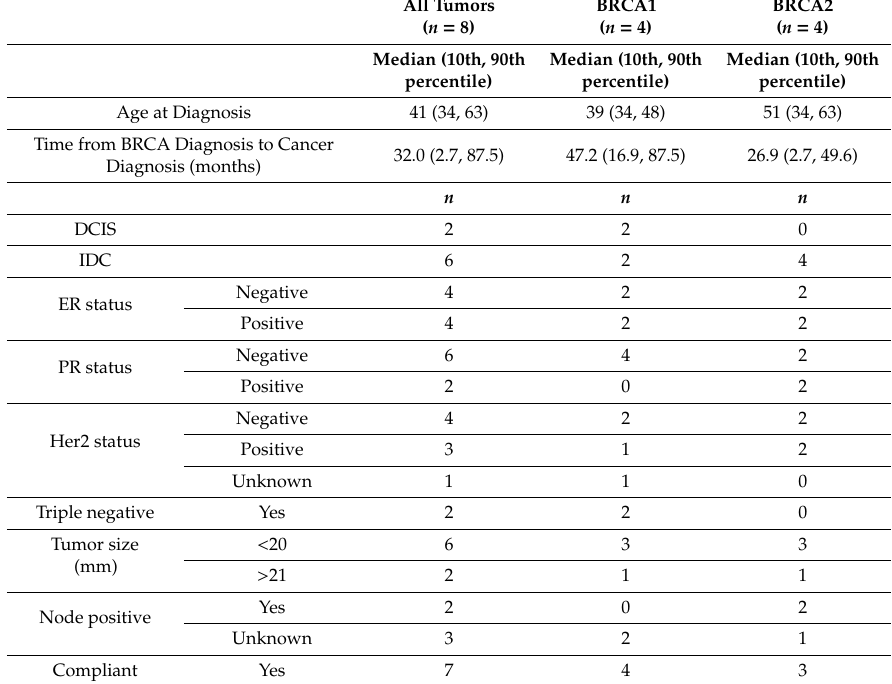
Table 3. Cancer Characteristics: PM /